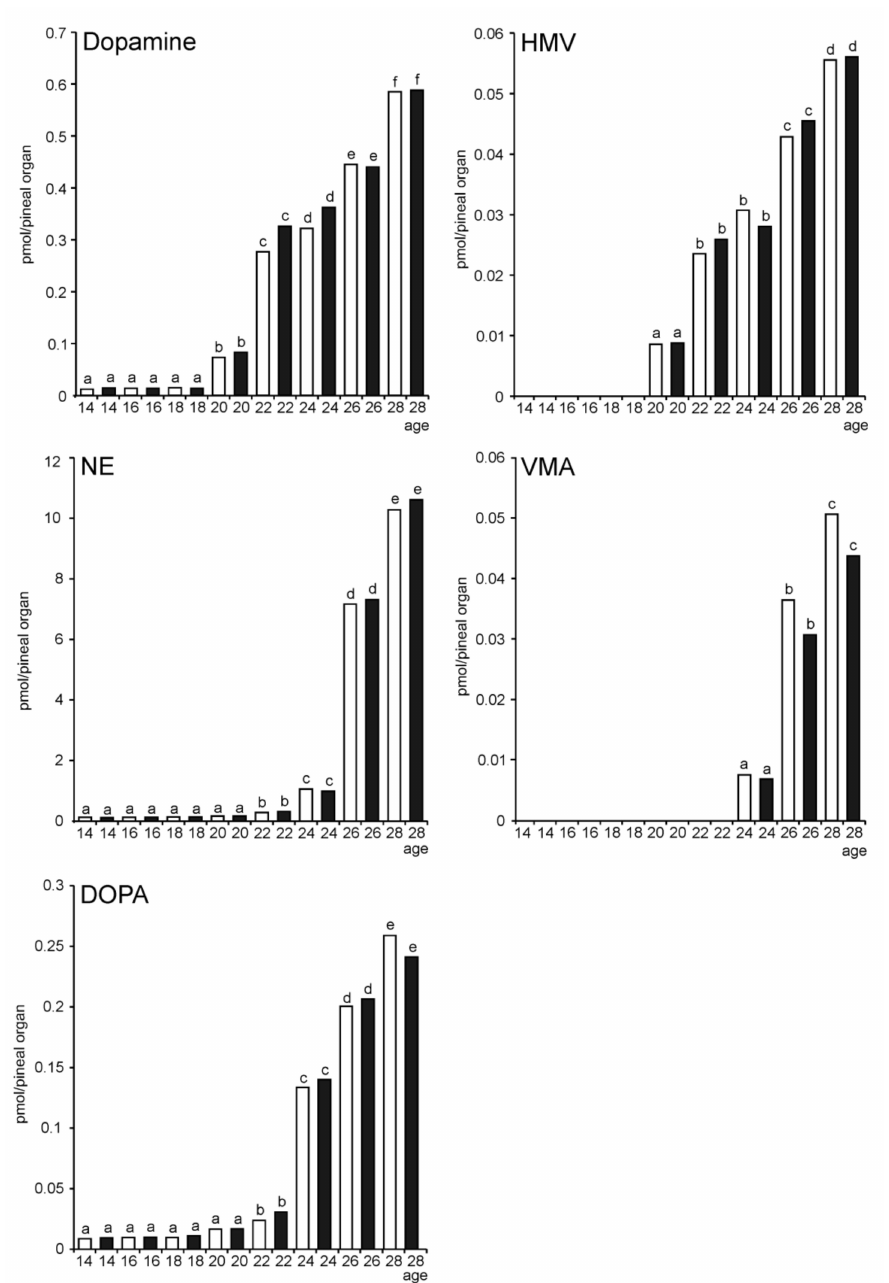
Figure 18. Content (means and SEM, n = 5) of norepinephrine (NE), vanillylmandelic acid (VMA), dopamine, homovanillic acid (HVA), and DOPA in the pineal organs of geese embryos at 14.00 (white columns) and 02.00 (black